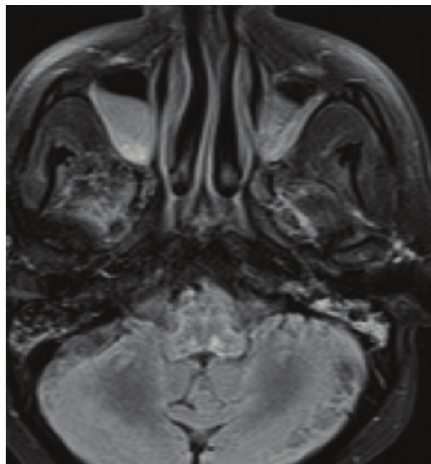
Figure 2: MRI brain showing increased T2 FLAIR signal in brain-